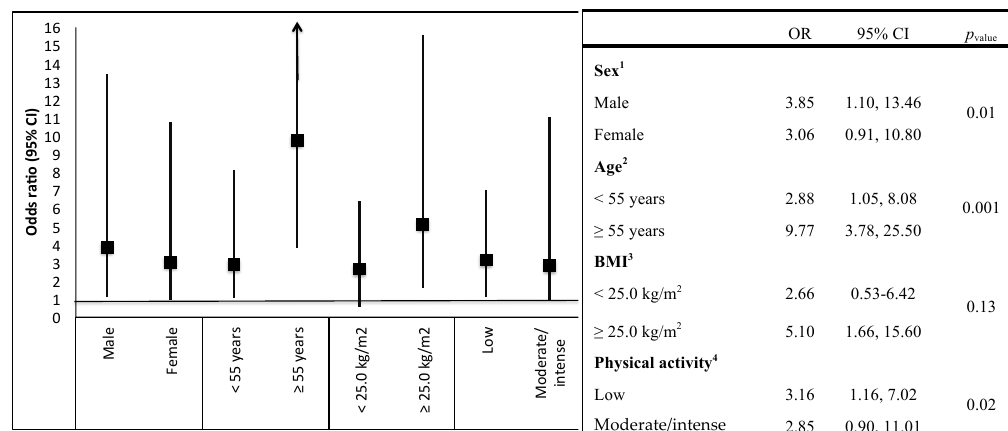
Figure 1. Subgroup analysis. Odds ratios (95% CI) for the association between extreme quintiles of the dietary inflammatory index (DII) and type 2 diabetes mellitus (T2DM). 1 Adjusted for age (years), physical activity (inactive vs. active/highly active), hours of television watching; tobacco use (current, past, and never), socioeconomic status (low, medium, and high), education (elementary and secondary education, high school, and Bachelor’s degree or higher), family history of diabetes mellitus (yes vs. no), personal history of hypertension (yes vs. no), medication use (yes vs. no), multivitamin use (yes vs. no), alcohol intake (gr/day), body mass index (<25.0 vs. ≥ 25.0 kg/m 2 ). 2 Adjusted for sex, physical activity (inactive vs. active/highly active), hours of television watching; tobacco use (current, past, and never), socioeconomic status (low, medium, and high); education (elementary and secondary education, high school, and Bachelor’s degree or higher), family history of diabetes mellitus (yes vs. no), personal history of hypertension (yes vs. no), medication use (yes vs. no), multivitamin use (yes vs. no), alcohol intake (gr/day), body mass index (<25.0 vs. ≥ 25.0 kg/m 2 ). 3 Adjusted for age (years), sex, physical activity (inactive vs. active/highly active), hours of television watching, tobacco use (current, past, and never), socioeconomic status (low, medium, and high); education (elementary and secondary education, high school, and Bachelor’s degree or higher), family history of diabetes mellitus (yes vs. no),